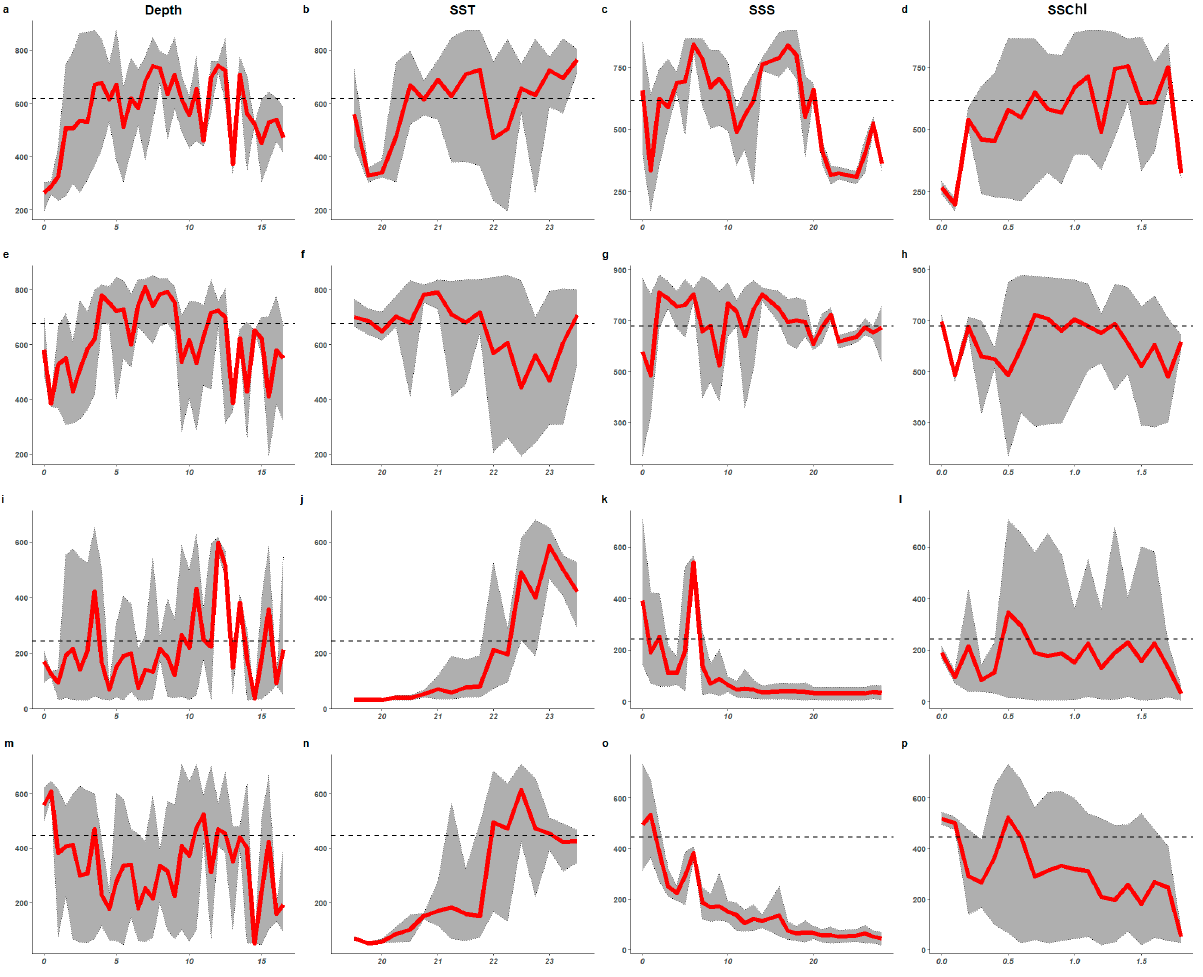
Figure 4. Response curves of explanatory variables (depth (Depth, m), sea surface temperature (SST, °C), sea surface salinity (SSS), and sea surface chlorophyll-a concentration (SSChl, mg/m 3 )) for the four larval fish species. (( a – d ) C. mystus ; ( e – h ) E. japonicus ; ( i – l ) P. sinensis ; ( m – p ) H. bleekeri ). Dashed lines represent cutoff levels by selecting a probability threshold that maximized the true skill statistic (TSS) value.